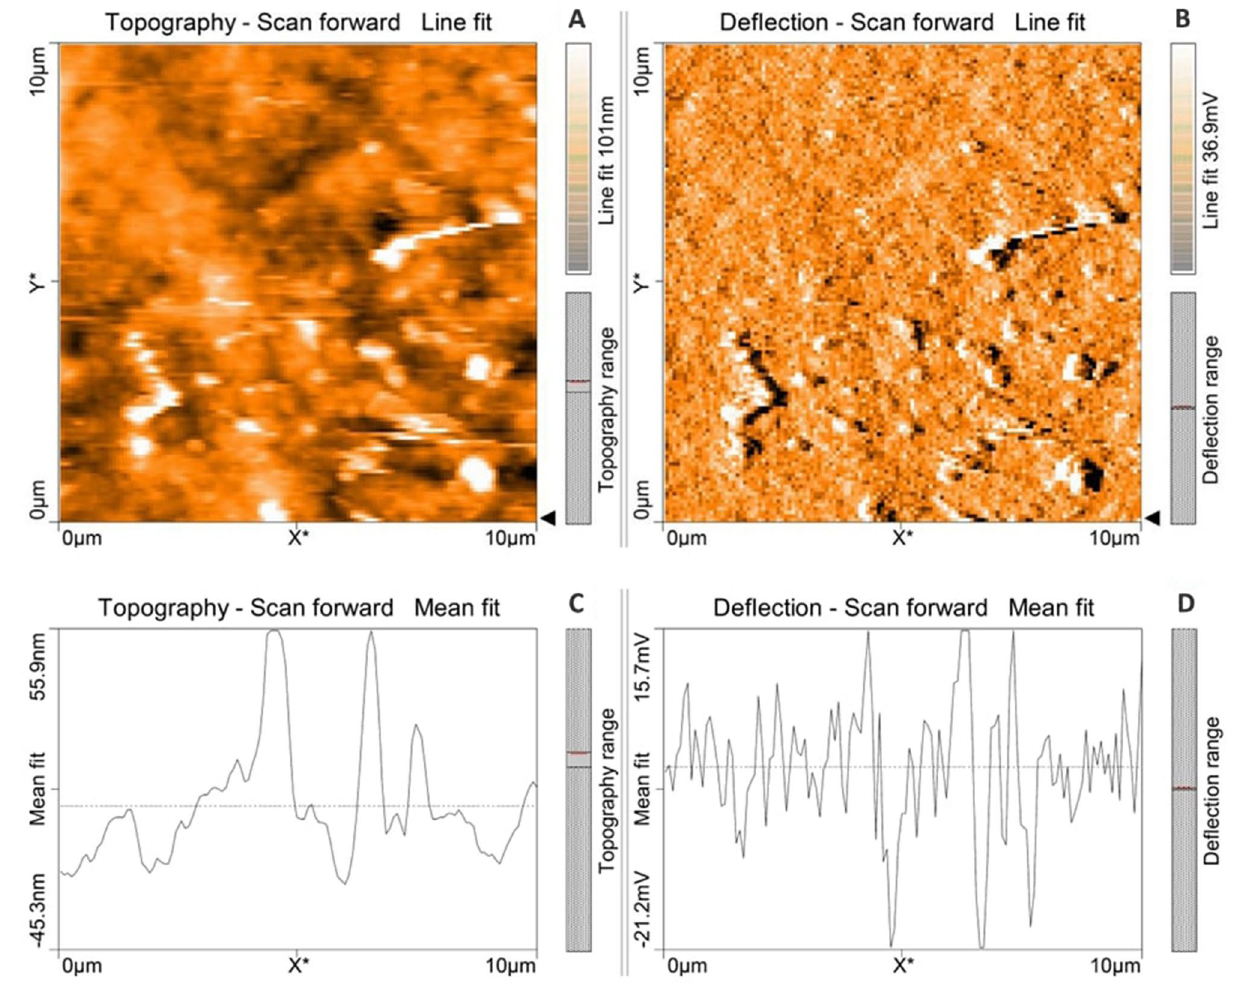
Figure 20. Atomic force microscopic results obtained for control (untreated) LDPE sheet of 10 µm 2 area: ( A ) Topography of the surface (Line fit); ( B ) Voltage deflection (Line fit); ( C ) Topography with mean fit; and ( D ) Voltage deflection with mean